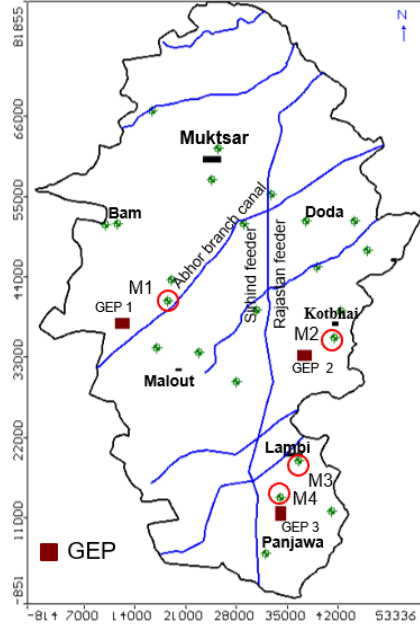
Figure 6. Location of the groundwater evaporation ponds in the study area ( x ‐ and y ‐ axes are in m).